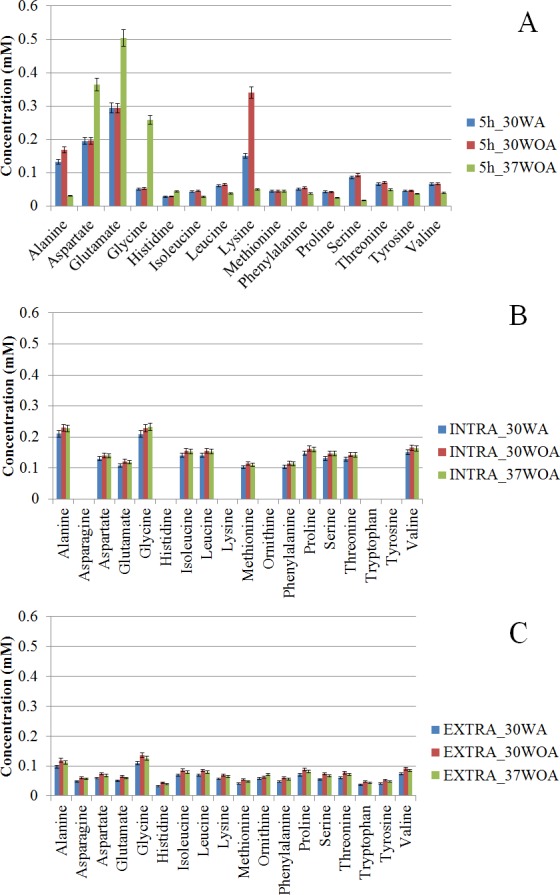
Comparative analysis of amino acids at different concentrations (mM).The proteinogenic amino acid (PAA) (A) and free amino acids (FAAs) obtained from intra- (B) and extracellular (C) of L. lactis were collected after five hours of cultivation. The concentrations of amino acid were obtained after five hours (5 h) of cultivation. 30WA represents 30 °C with agitation, 30WOA represents 30 °C without agitation and 37WOA represents 37 °C without agitation. Values are given as mean ± standard deviation (n = 5, biological replicates).